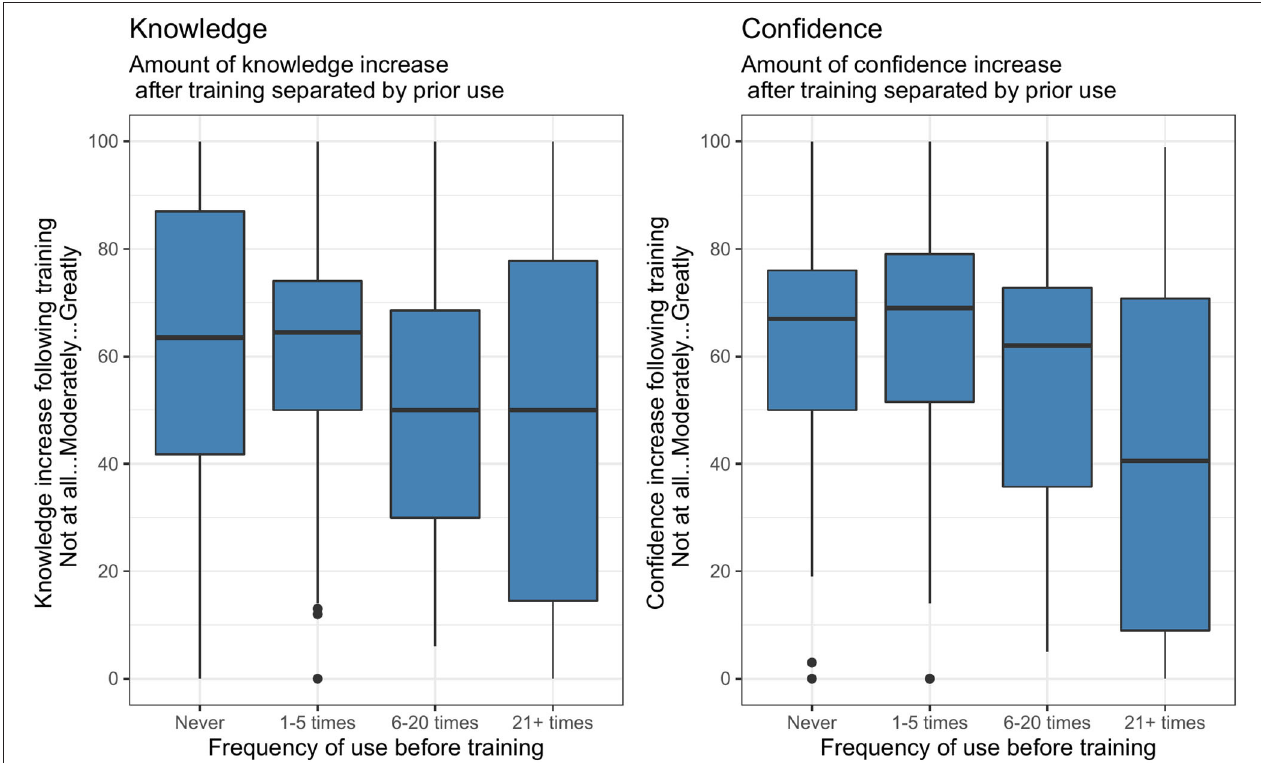
FIGURE 1 | Self-assessed changes in knowledge and confidence post-training, separated by frequency of use in the year before. Changes in knowledge and confidence were more pronounced in those who had had lesser exposure to